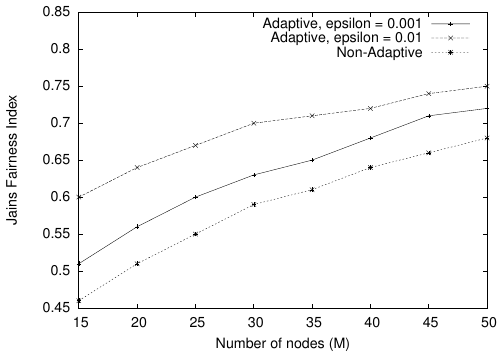
Figure 4: JFI (heterogeneous